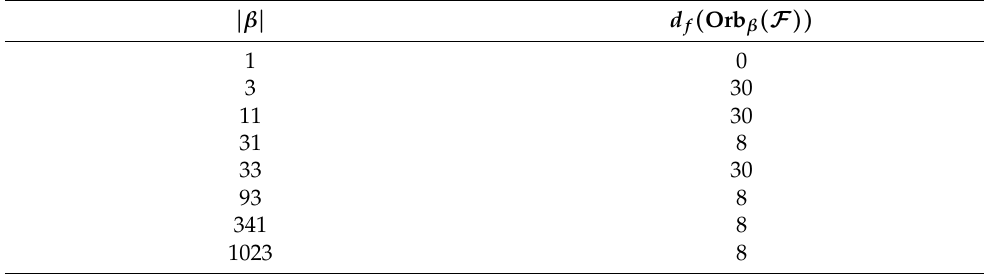
Table 2. Distance of all the β -cyclic orbit flag codes generated by F